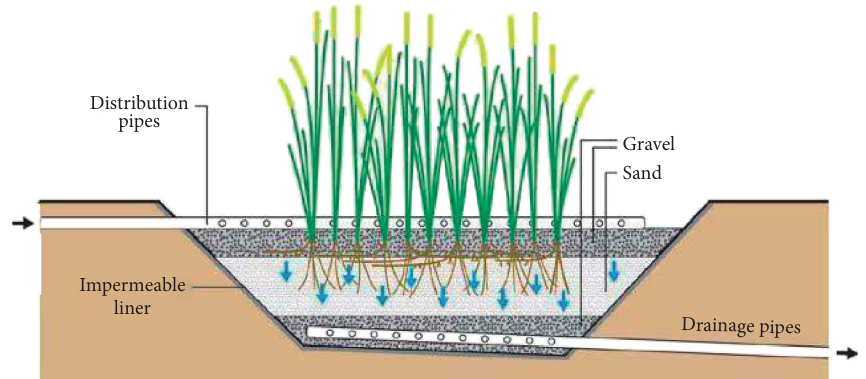
Figure 3: Schematic cross section of a vertical-flow constructed wetland (VFCW) (source: [13]).